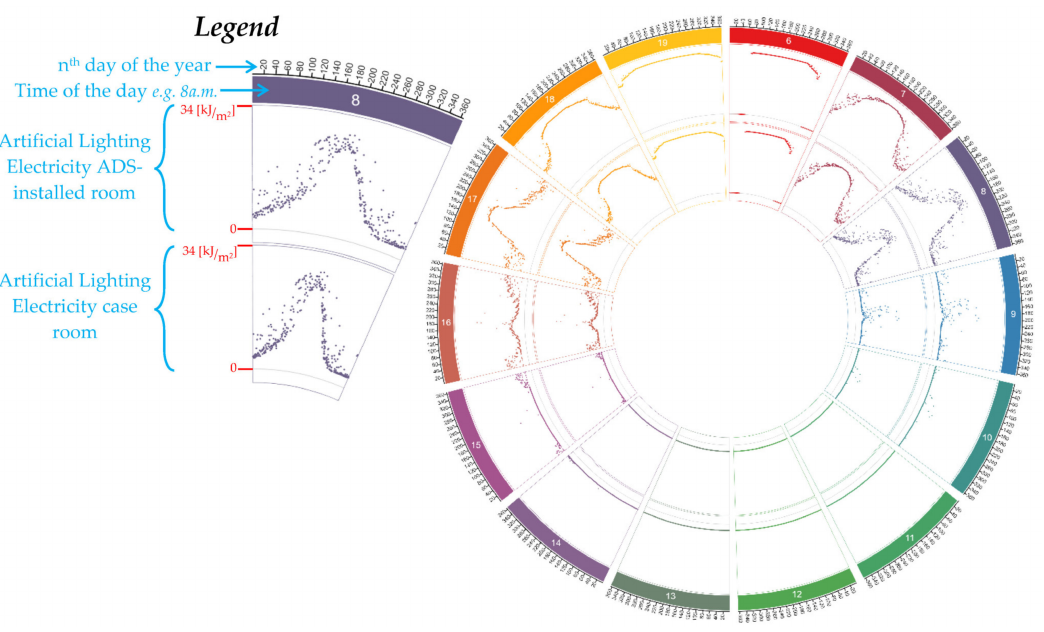
Figure 18. A yearly measurement and comparison between the reference room and ADS-installed lighting electricity consumption on an hourly basis.